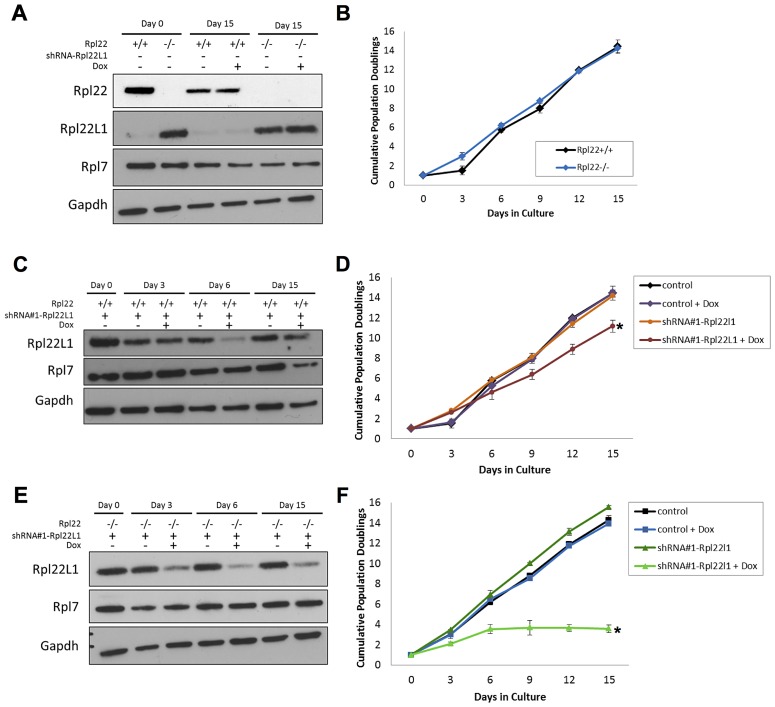
Acute knockdown of Rpl22l1 expression impairs cellular growth.(A) Lysates isolated Rpl22+/+ and Rpl22−/− 3T9 cells treated with or without doxycycline were collected to assess levels of Rpl22 or Rpl22L1 by Western blot analysis. GAPDH was used as a loading control. (B) Growth of Rpl22+/+ and Rpl22−/− 3T9 cells was compared. Levels of Rpl22l1 were analyzed by Western blot analysis to confirm that the Rpl22l1-shRNA knocked down levels of Rpl22l1 in doxycycline-treated Rpl22+/+ (C) and Rpl22−/− (E) 3T9 cells transduced with the shRNA construct. Growth of Rpl22+/+ (D) and Rpl22−/− (F) 3T9 cells transduced with each shRNA construct was determined. Results are representative of 2 independent experiments with error bars representative of ±SD. Statistical significance is indicated (*, p<0.05 compared to untreated control).